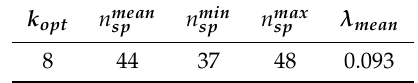
Table 1. Optimal number of clusters obtained by means of the Davies-Bouldin index ( k opt ), mean number of species per cluster ( n mean sp ), minimum number of species per cluster ( n min sp ), maximum number of species per cluster ( n mean sp ) and mean non-uniformity coefficient per cluster ( λ mean ), using a reduction tolerance (cid:101) DRGEP = 0.005 for the SKM partitioning. k